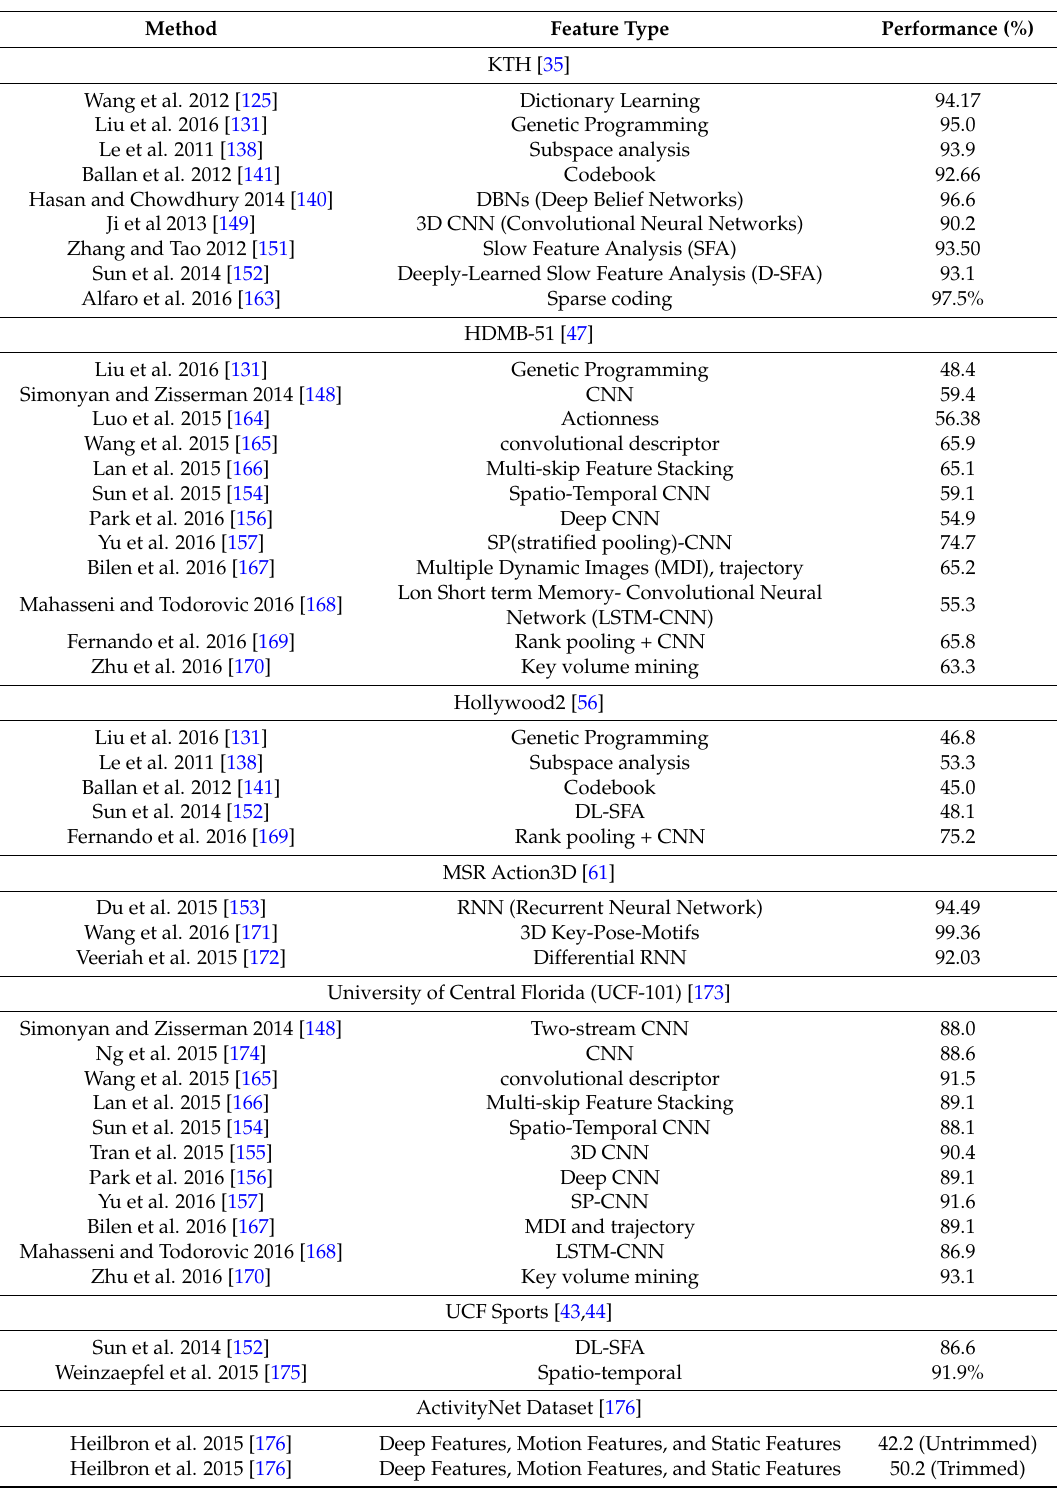
Table 3. Comparison of Learning-based action representation